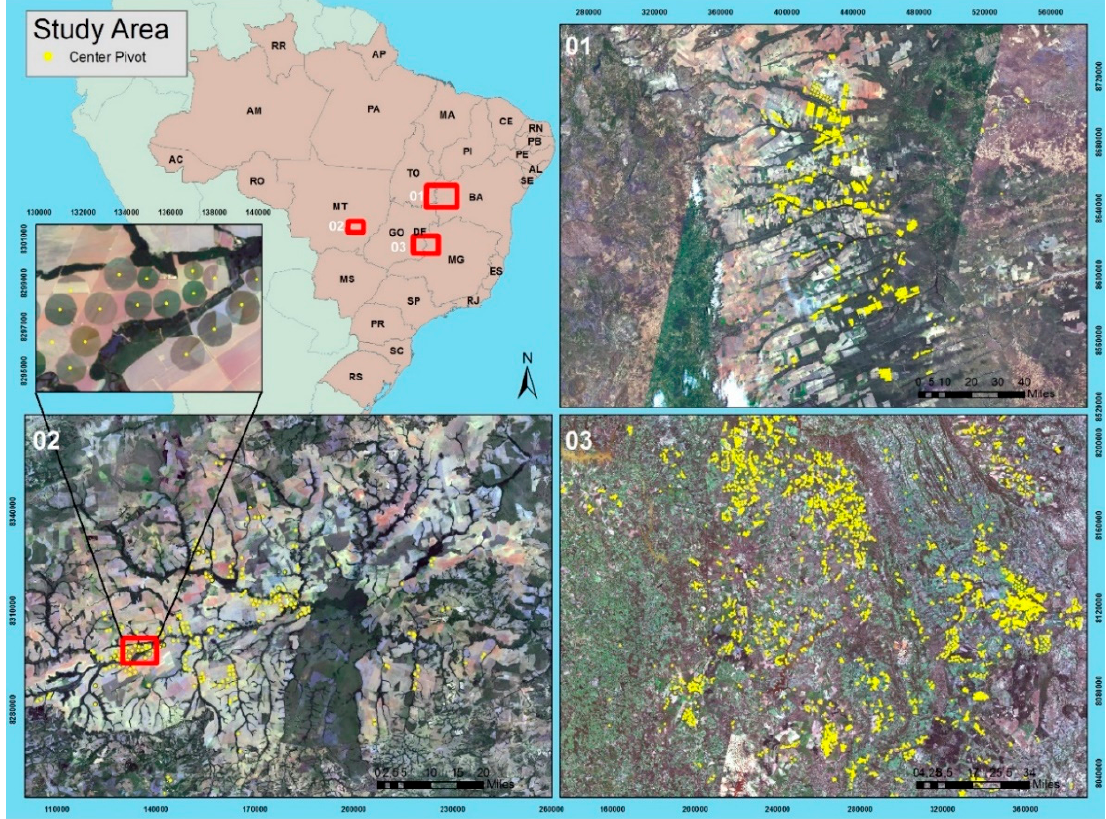
Figure 2. Location map of the study areas: (1) Western Bahia; (2) Mato Grosso; and (3) Goiás/Minas Gerais.